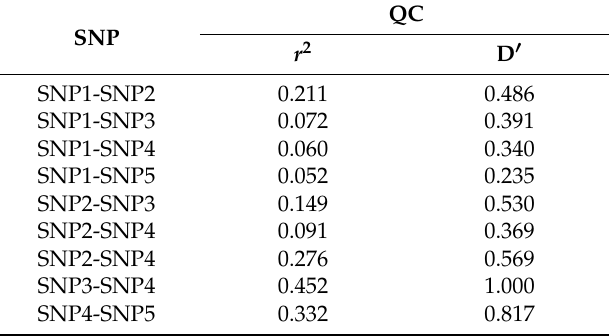
Table 3. Estimated values of linkage equilibrium between five SNPs in Qinchuan